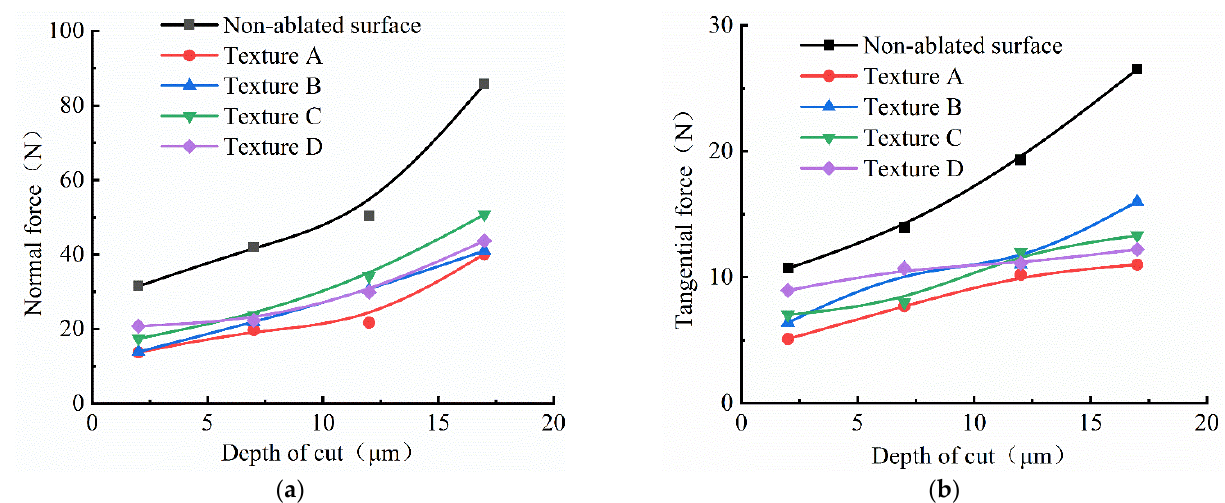
Figure 9. Influence of depth of cut on grinding force with different textures; ( a ) depth of cut vs. normal force; ( b ) depth of cut vs. normal force.